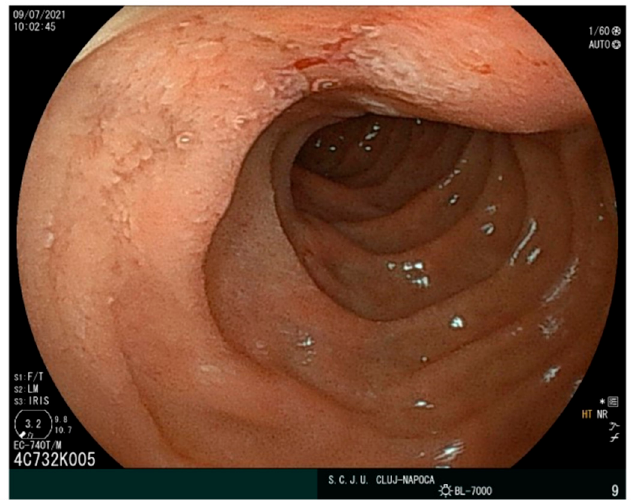
Figure 3. Ulceration adjacent to Vater’s ampulla, covered by fibrin.